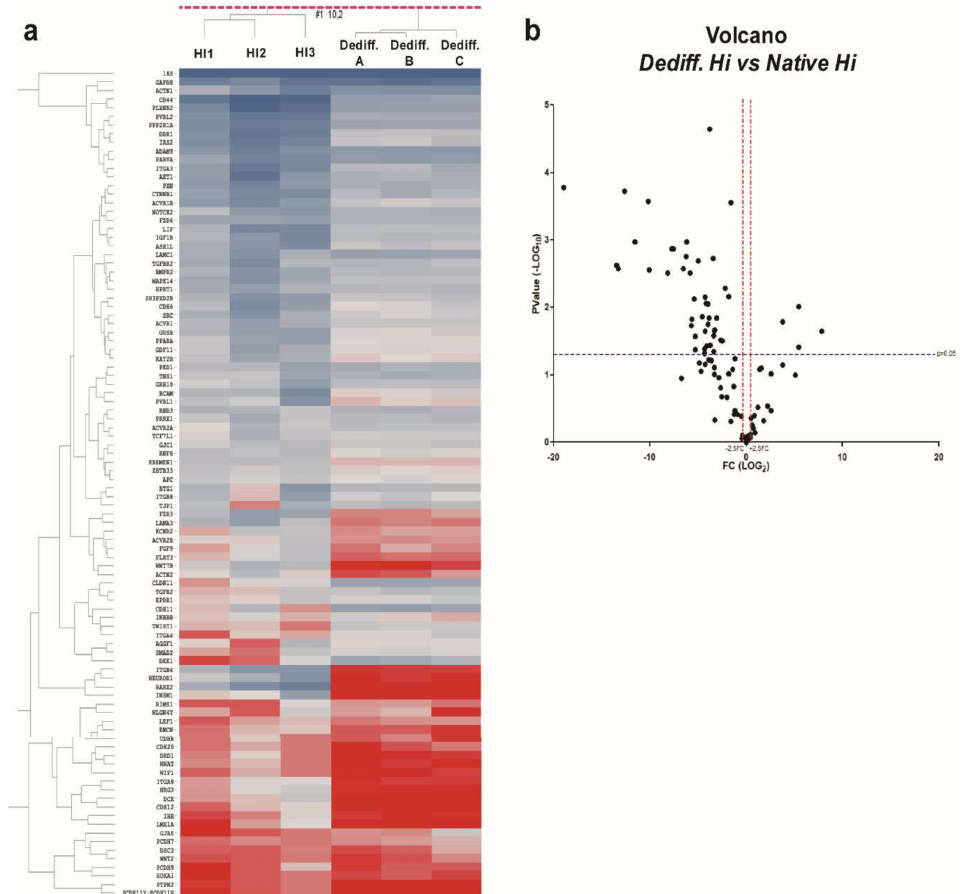
Figure 4. MicroRNA target genes expression profiling. ( a ) Hierarchical clustering analysis showing expression levels of selected target genes in human native islets (Hi1, Hi2, Hi3) and dedifferentiated islet cells (Dediff.A, Dediff.B, Dediff.C). Expression values of each target gene are reported as ∆ Ct and fitted into color scale (blue: high expression; red low/null expression). ( b ) Volcano plot analysis showing differentially expressed genes (selected based on the functional bioinformatic analysis) in dedifferentiated human islet cells ( n = 3) vs. native islets ( n = 3). Single black dots represent each detected gene based on the relative mean fold change (-Log FC) and p -values. Fold change cutoff (red lines) was set at 2.5-fold while p -values cutoff (blue line) was set at 0.05 based on Student’s t -test on normally distributed ∆ Ct